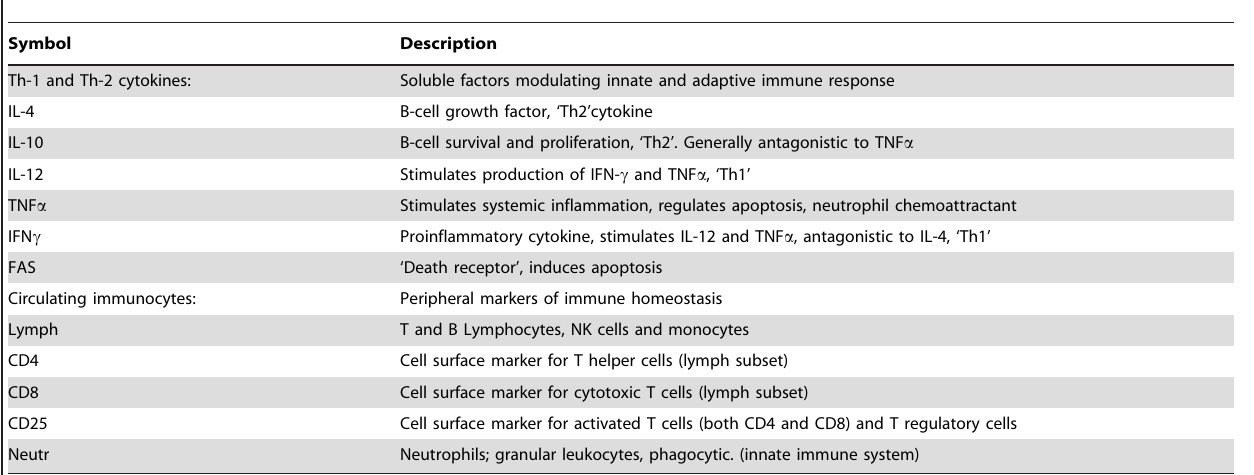
Table 1. List of immunological response parameters used in the analysis.